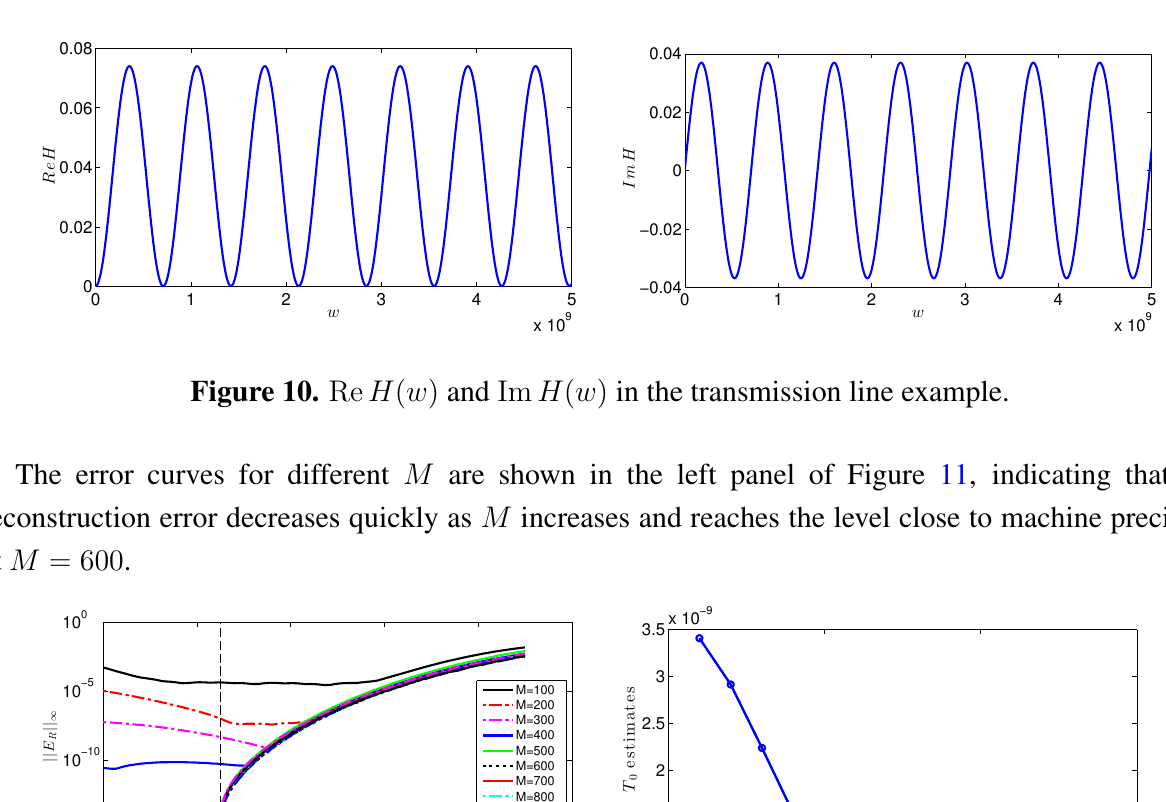
Figure 11. Left panel: evolution of || E The vertical dashed line indicates the time delay T the delay time in the transmission line example using critical transition times T The dashed line corresponds to the exact delay T